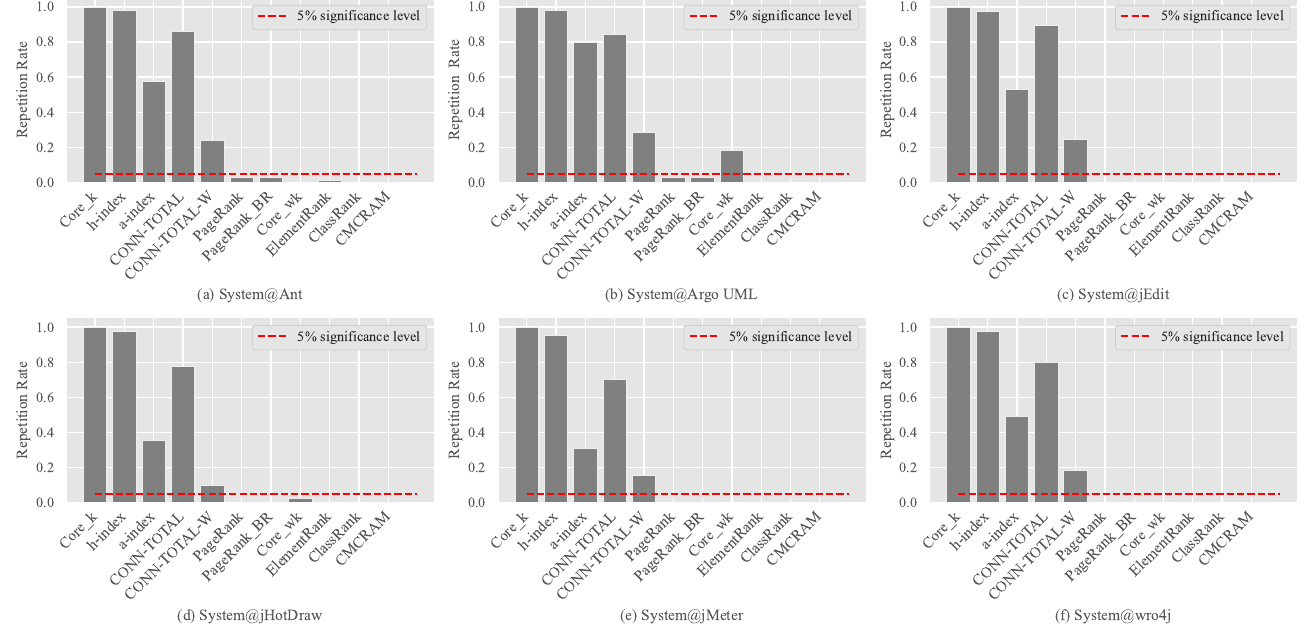
Figure 3. The comparison of repetition rate with baseline approaches for the top-15%